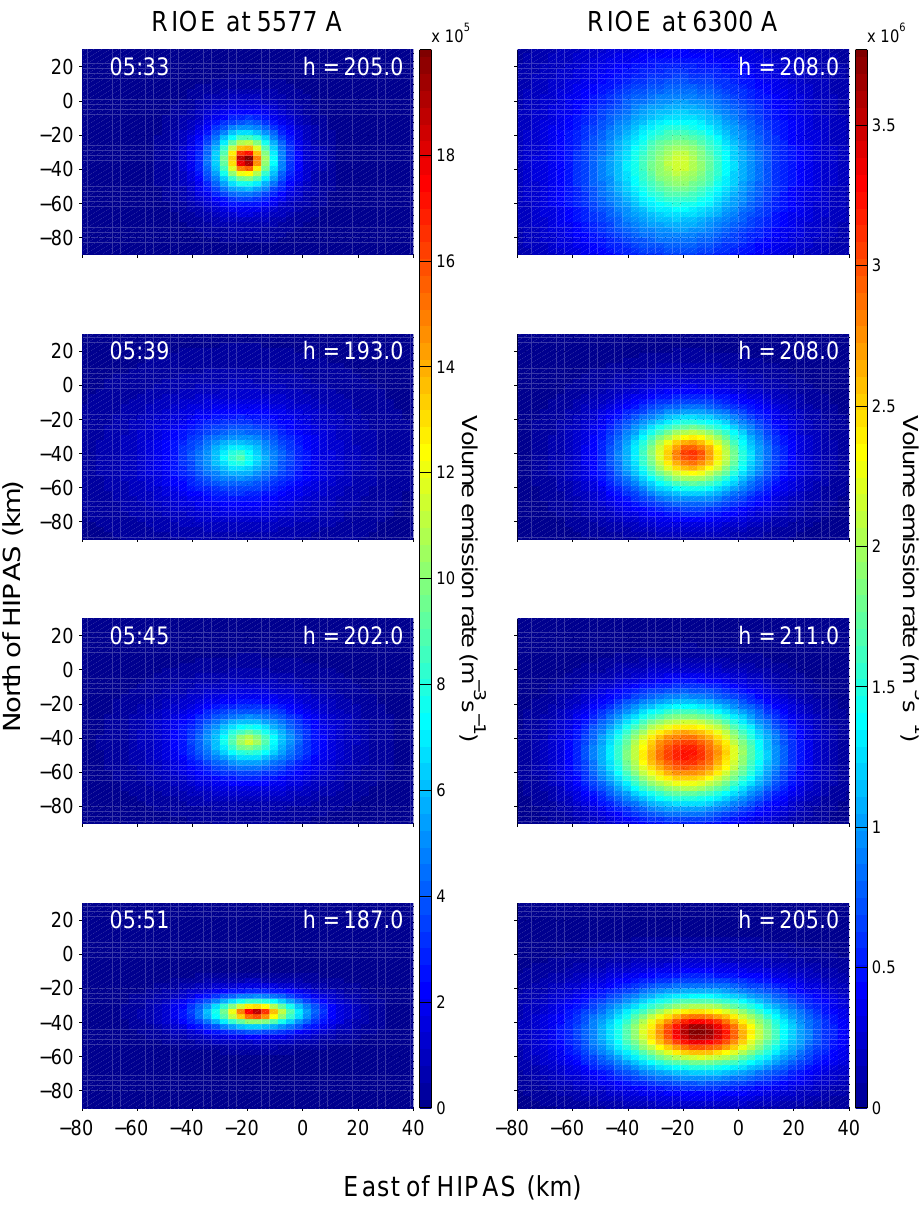
Fig. 8. The left and right panels show the horizontal cuts through the maximum of the enhanced volume emission at 5577 and 6300 ˚A, respectively, at the altitudes marked. Note that the region of enhanced volume emission rates are spatially wider with a broader peak at 6300